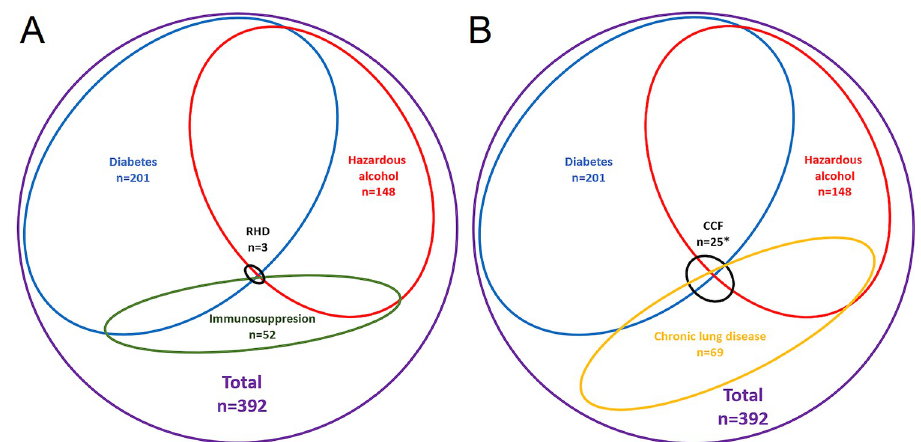
additional patient with CCF who had an active malignancy, but no diabetes, chronic lung disease or history of hazardous alcohol use. RHD: Rheumatic heart disease. CCF: Congestive cardiac failure. Only the patients with diabetes mellitus, hazardous alcohol use, chronic lung disease, immunosuppression, RHD and CCF are shown in the figure. There were, in addition, 53 patients with chronic kidney disease, 35 patients with an active malignancy and 56 patients in whom no risk factor was